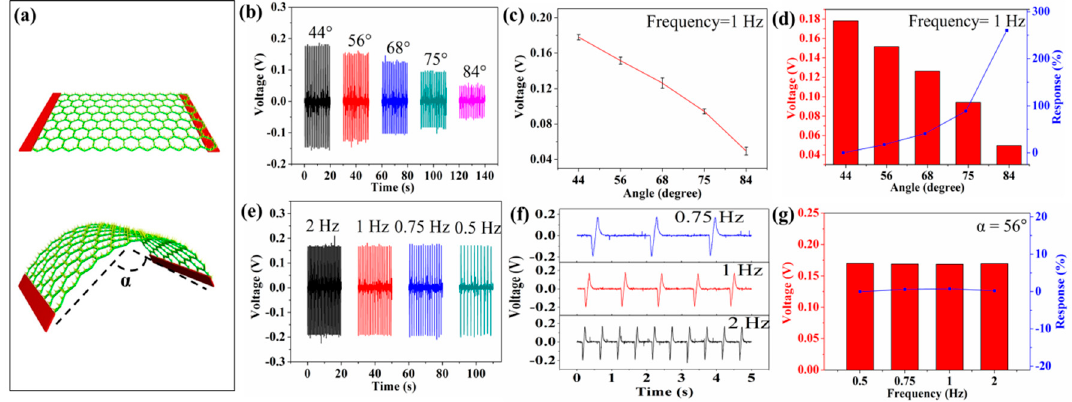
Figure 3. The piezoelectric output of self-powered textiles under applied deformation. ( a ) The bending deformation on the textiles. ( b ) The output piezoelectric voltage of the device at different bending angles (frequency is maintained at 1 Hz). ( c , d ) The relationship between piezoelectric voltage and bending angle. ( e ) The output piezoelectric voltage of the device at different frequencies (the bending angle is maintained at 56°). ( f ) The details of the voltage signal. ( g ) The relationship between piezoelectric voltage and frequency.